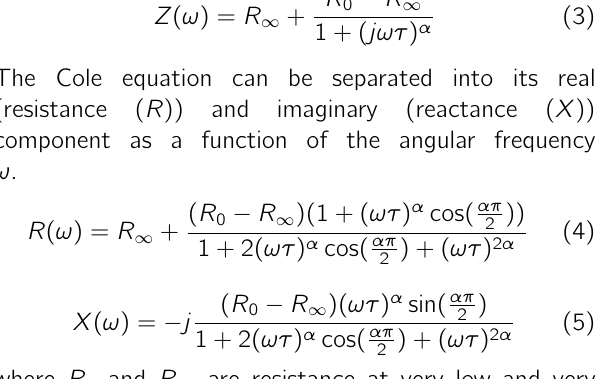
Figure 2: Plot of mean impedance values with 95 % confidence interval against frequency for 0 to 10 hours duration.